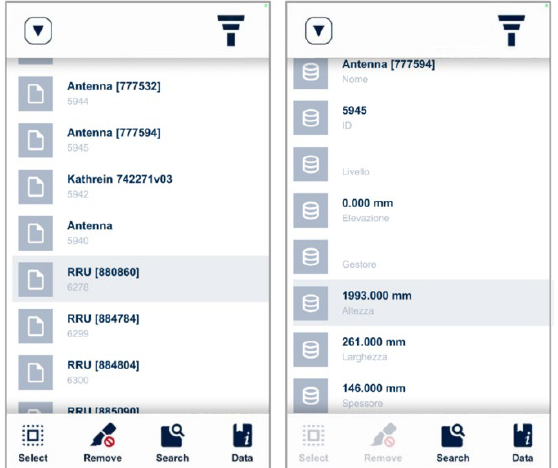
Figure 3. Screenshots of the data views of the developed app. The left view shows the list of available elements, while the right one shows the attributes of a single element.